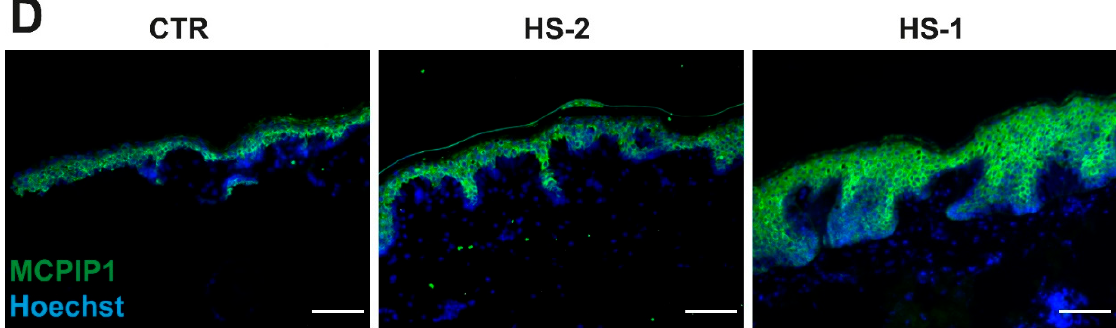
Figure 1. Increased expression of monocyte chemotactic protein-1-induced protein-1 (MCPIP1) in the hidradenitis suppu- rativa skin. ( A ) qRT-PCR analysis of MCPIP1 (ZC3H12A) transcript level in the healthy human skin (CTR), non-lesional hidradenitis suppurativa patients’ skin (HS-2) and lesional HS patients’ skin (HS-1) ( n = 14). ( B ) Representative Western blot for MCPIP1. β -actin was used as the loading control. ( C ) Densitometric quantification of MCPIP1 protein level ( n = 4). ( D ) Representative MCPIP1 immunofluorescence staining of the skin sections. Scale bar 100 μ m. Data represent the mean ± SEM. * p < 0.05, *** p < 0.001 by one-way ANOVA.